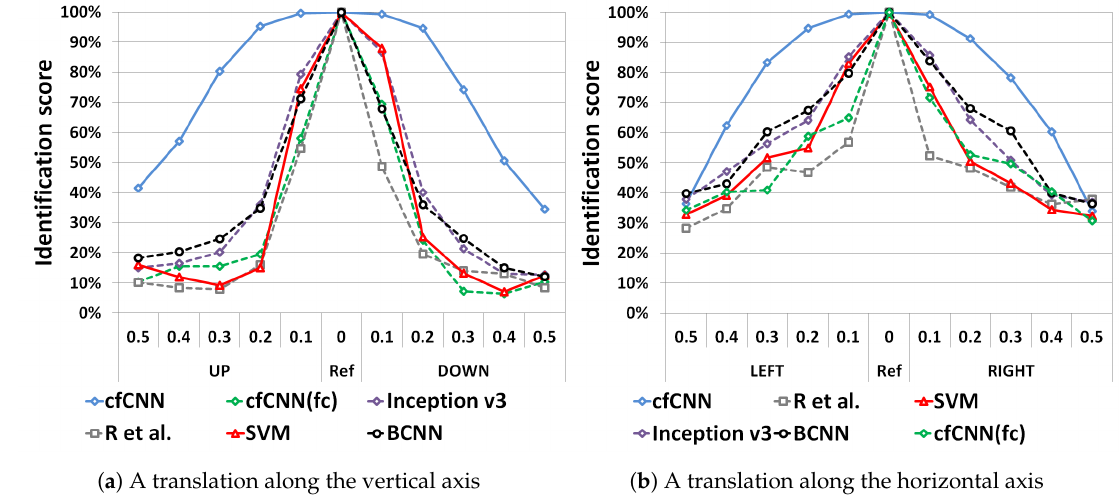
Figure 9. The global identification results for translated examples on the TTS dataset.